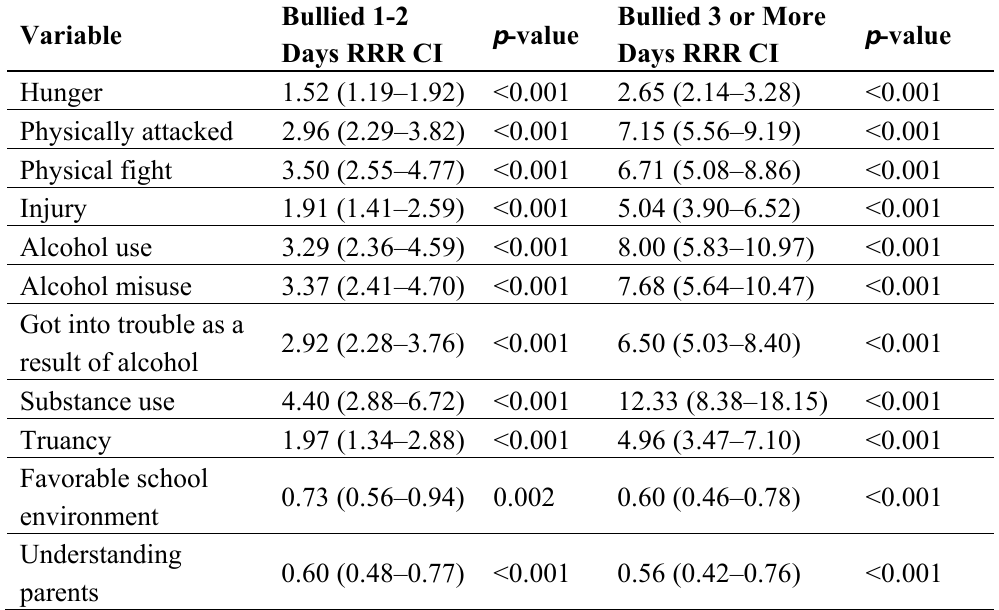
Table 3. Age- and sex-adjusted analyses of selected variables according to bullying category among adolescents in Ghana.